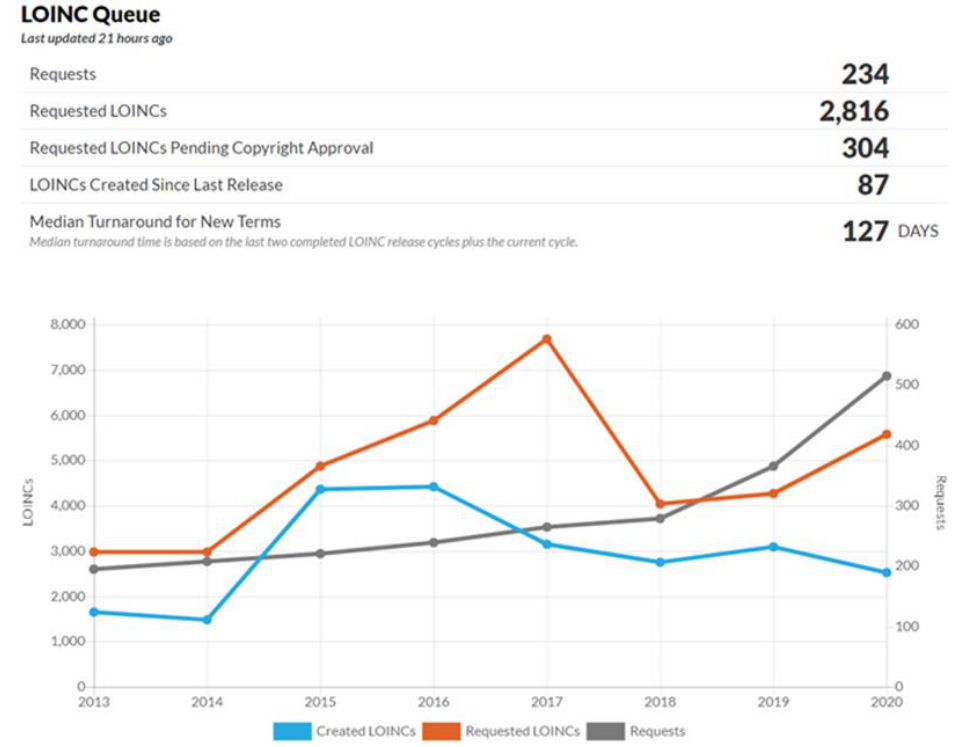
Figure 7. Frequency of LOINC additions.